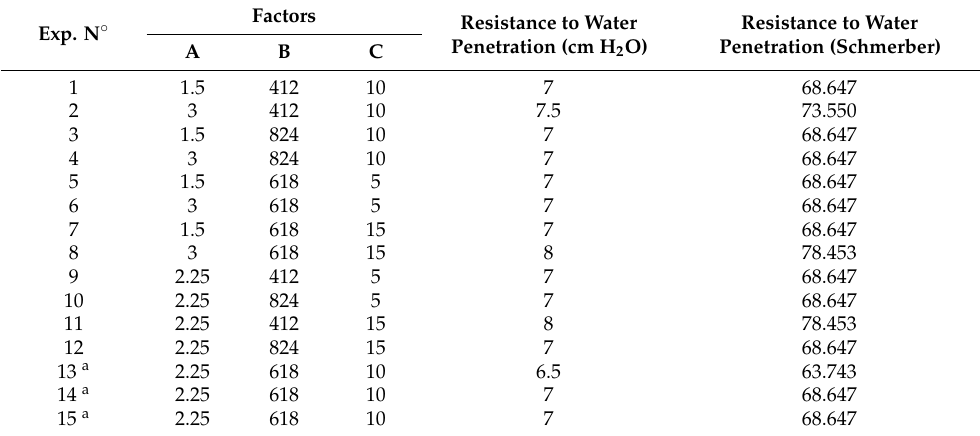
Table 7. Resistance to water penetration values of the treated